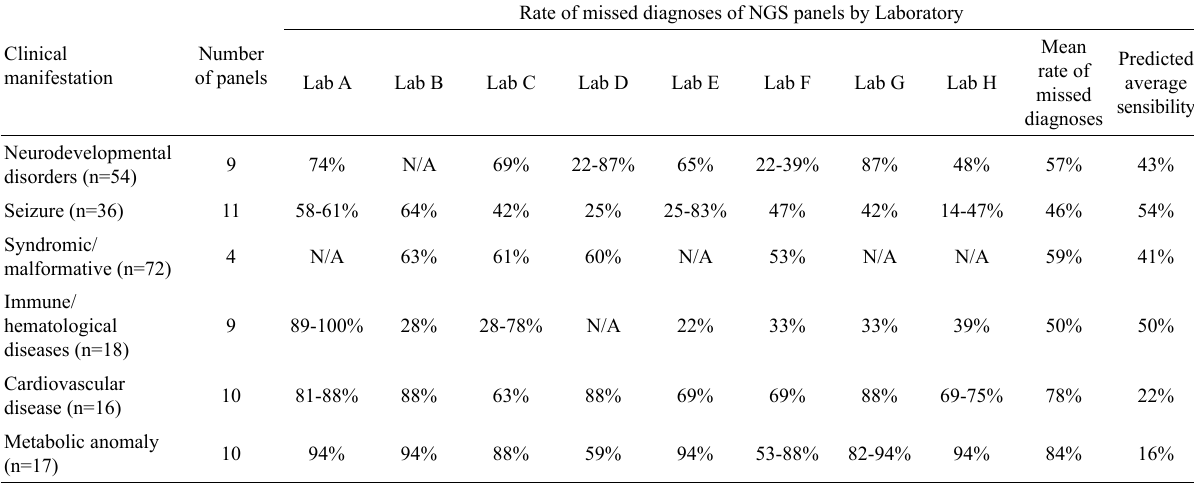
Table 1 ‒ Rate of molecular diagnoses missed by NGS panels from the eight laboratories per clinical manifestation. In the first column, “n” represents the number of patients in the group; Labs A through E are Brazilian national laboratories, while F through H are international; column “Mean” represents the mean of missed diagnoses per group of Clinical